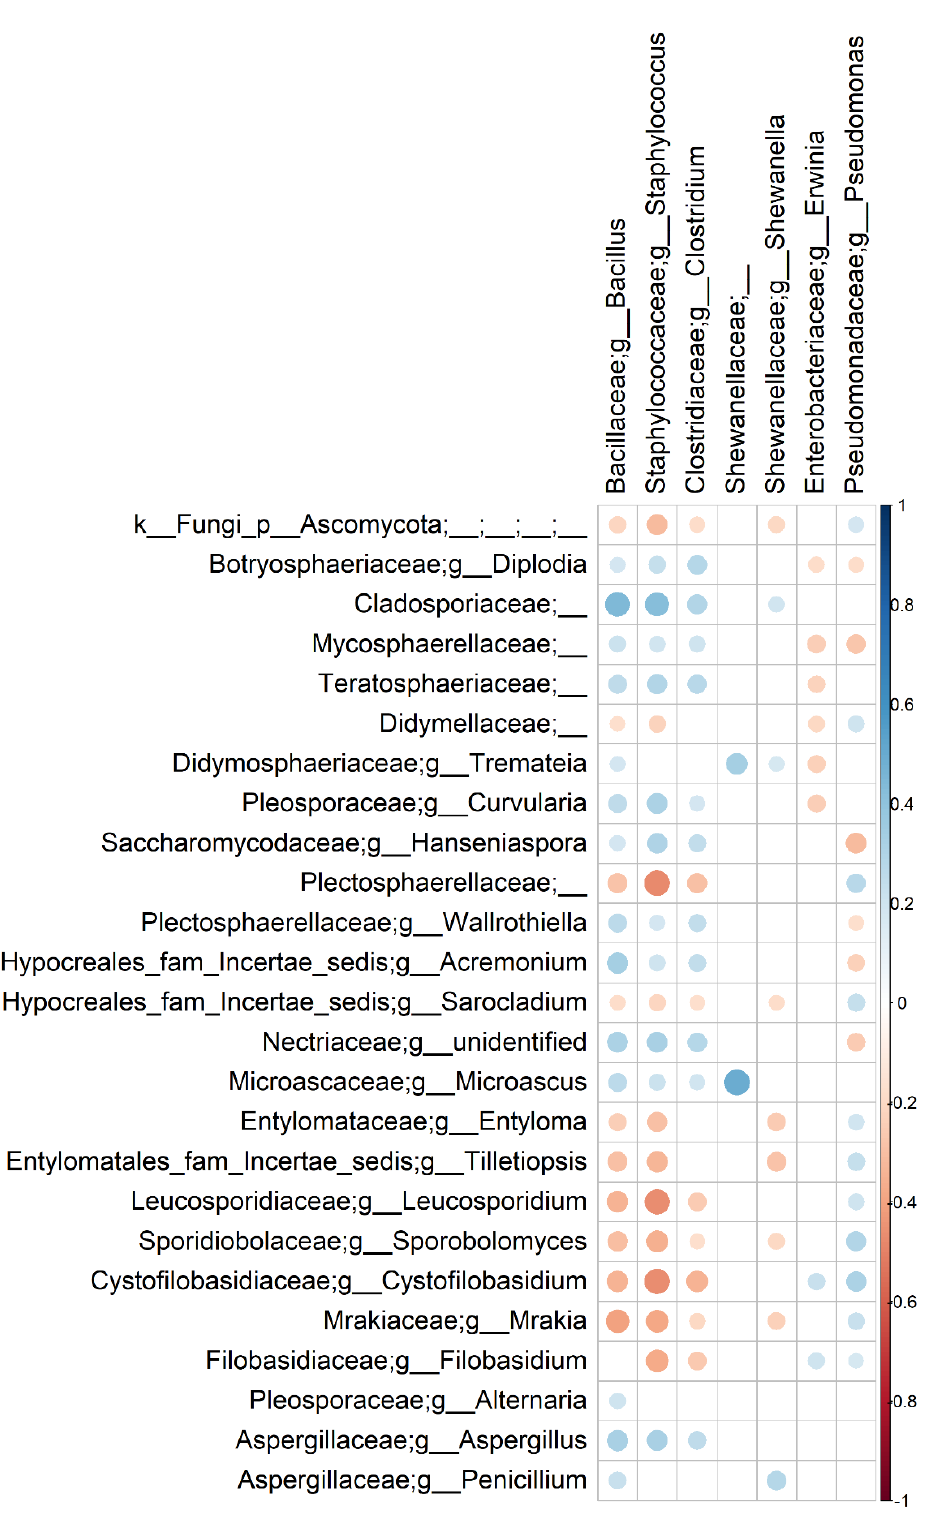
Figure 8. Spearman’s rank correlation matrix of bacterial and fungal taxa. Strong correlations are indicated by large circles, whereas weak correlations are indicated by small circles. The colors of the scale bar denote the nature of the correlation, with 1 indicating a perfectly positive correlation (dark blue) and − 1 indicating a perfectly negative correlation (dark red) between two microbial taxa. Only significant correlations (FDR < 0.05) are shown.